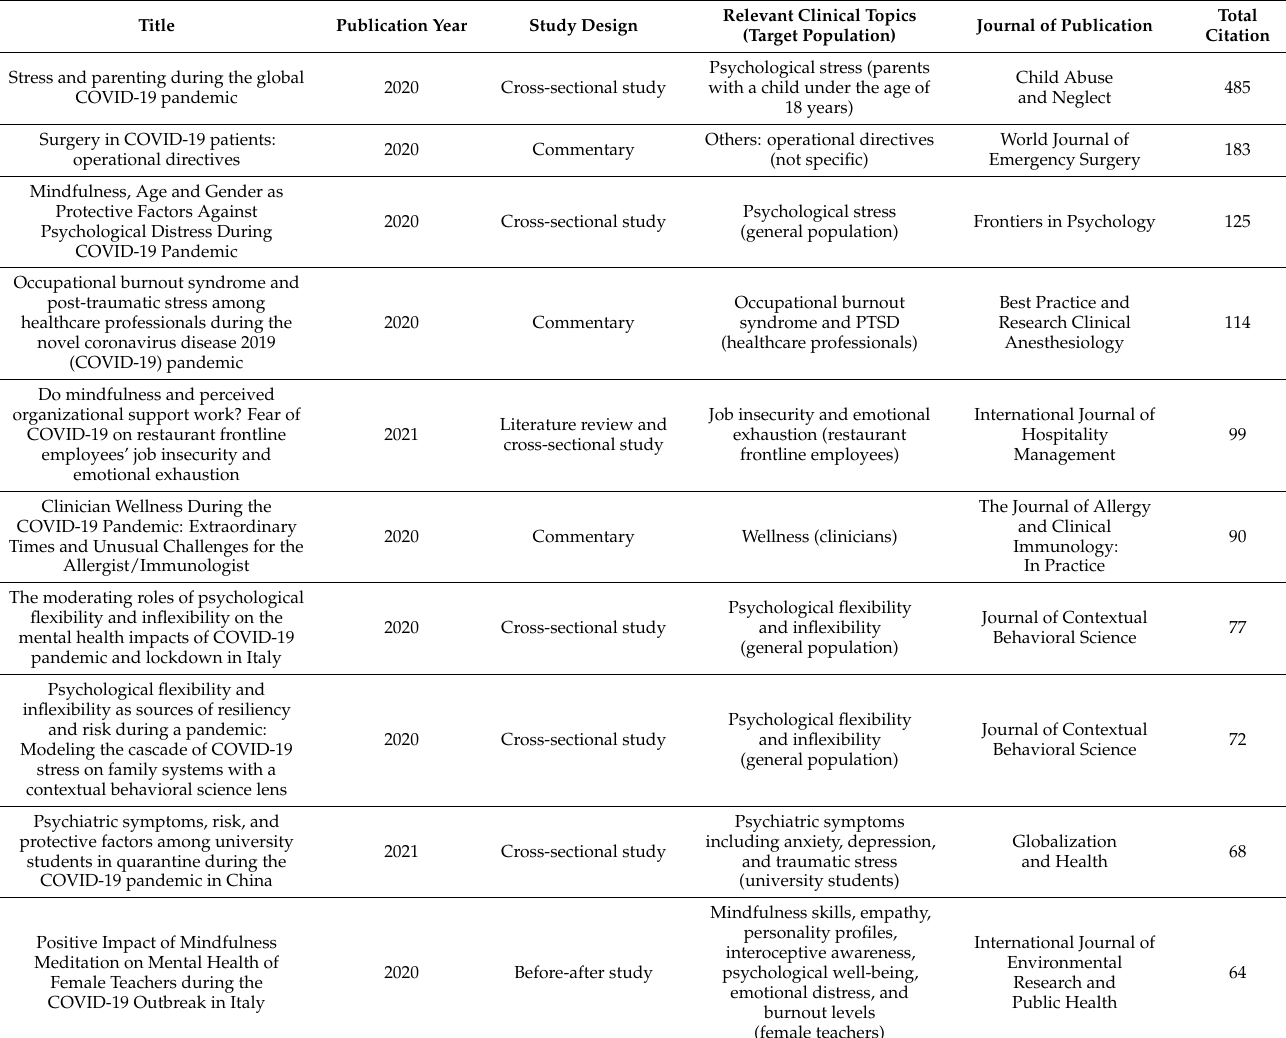
Table 3. Top 10 most frequently cited